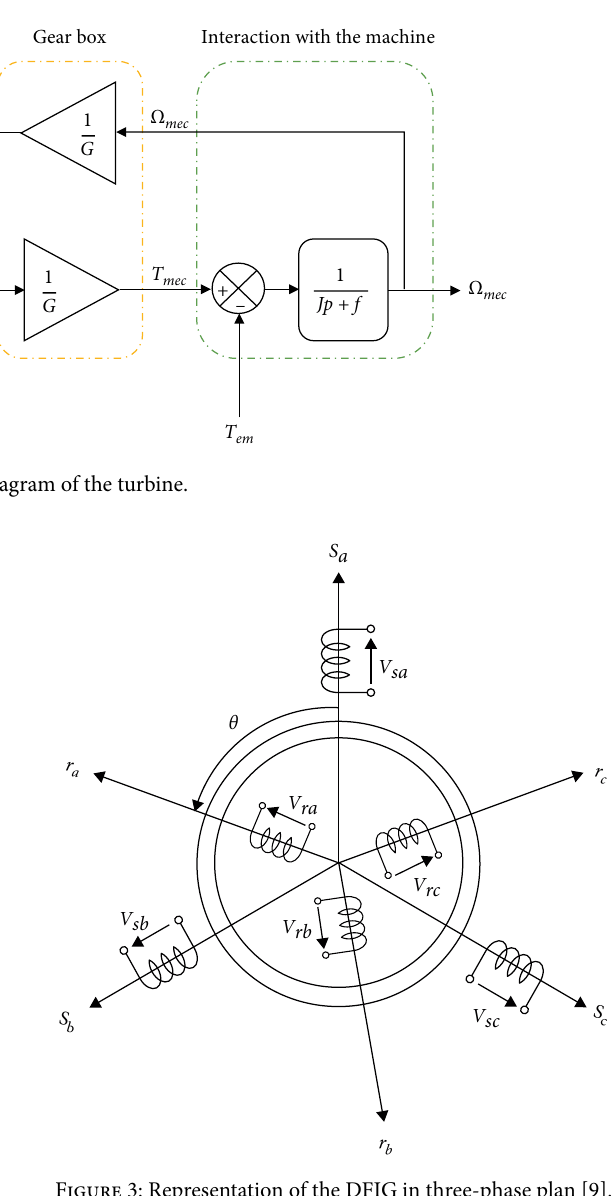
Figure 3: Representation of the DFIG in three-phase plan